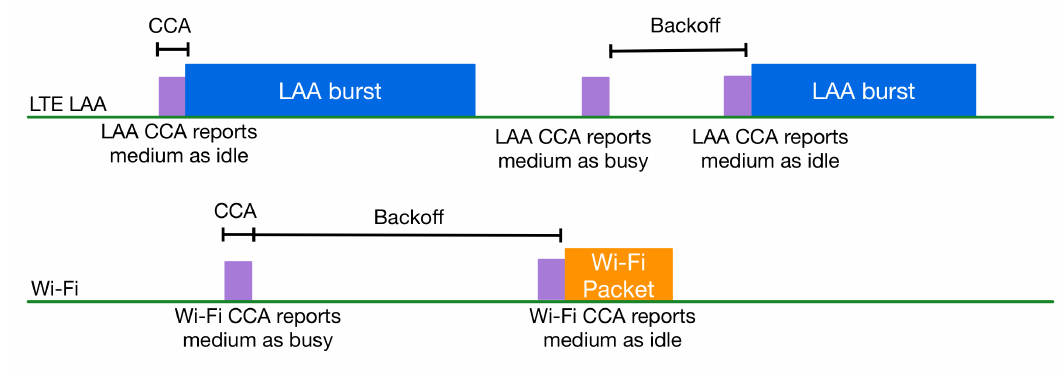
Figure 5. LTE Licensed-Assisted Access (LAA) and Wi-Fi coexistence.